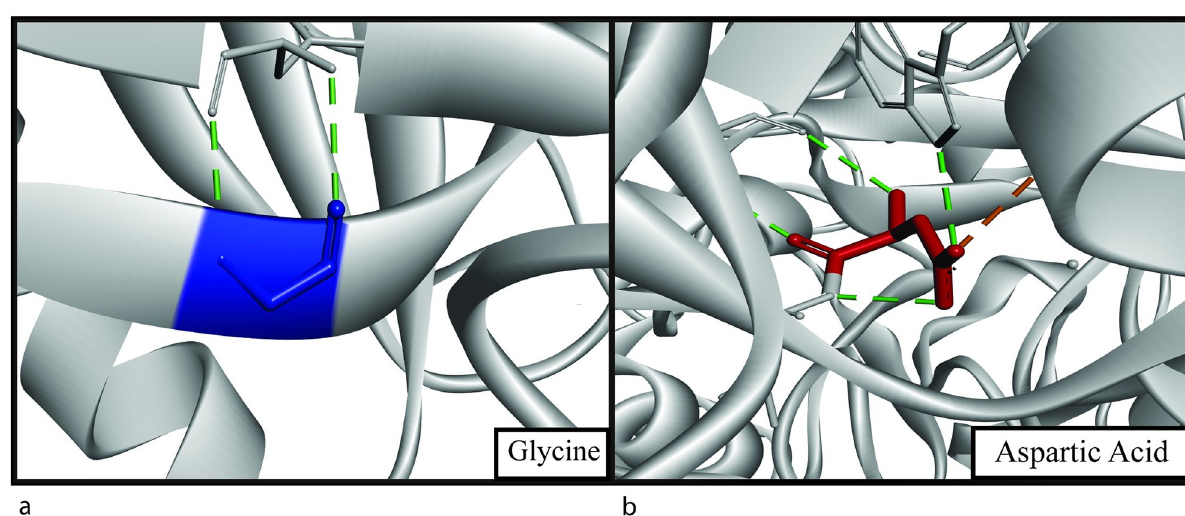
Fig 4. (a) Structural analysis showing Gly493 (blue) of native structure having 2 hydrogen bonds (green) and (b) Asp493 (red) of mutant structure having 4 hydrogen bonds (green) and a salt-bridge bond (orange).